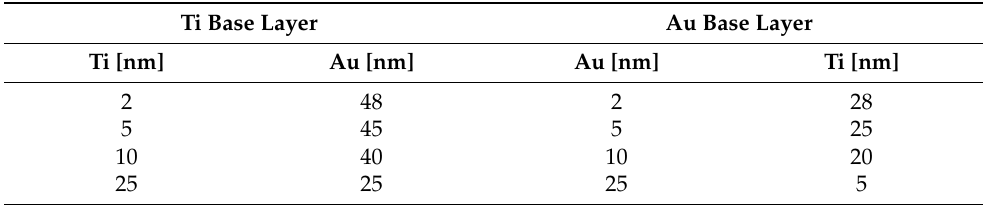
Table 1. Overview of the prepared samples. Two series with the opposite order of deposited metals (titanium, gold) were prepared. In each series, four types of samples differing in the ratio of the thicknesses of the metallic layers were